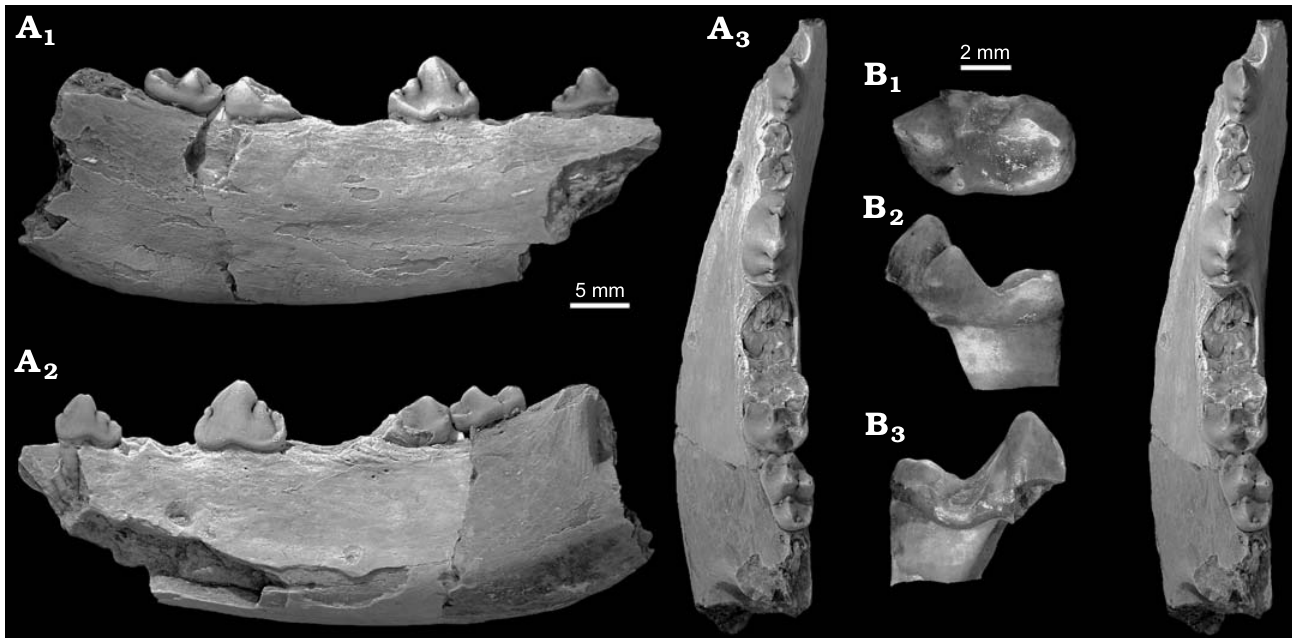
Fig. 3. Canidae of the Eastgate LF, basal-most unit of the Monarch Mill Formation, Barstovian (Miocene), Churchill County, Nevada, USA. A . Tomarctus brevirostris , Cope, 1873, UCMP 141908, left dentary with p2, p4, partial m1, and m2 in lingual (A 1 ), labial (A 2 ), and occlusal (A 3 , stereopair) views. B . Leptocyon sp., UCMP 141482, right m1 in occlusal (B 1 ), lingual (B 2 ), and labial (B 3 )